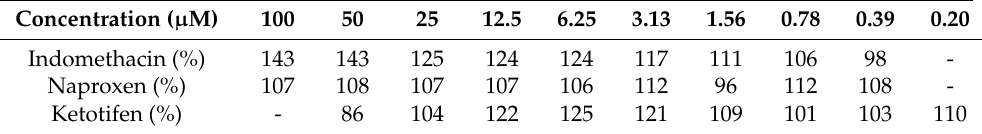
Table 5. Percentage viability at different concentrations of ketotifen, naproxen, and indomethacin. Concentration ( μ M)